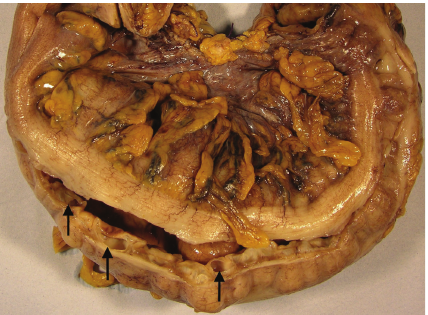
Figure 2: Macroscopic appearance of the resected recto-sigmoid colon. Arrows show numerous air-filled cystic spaces varying in size from few millimeters to more than a